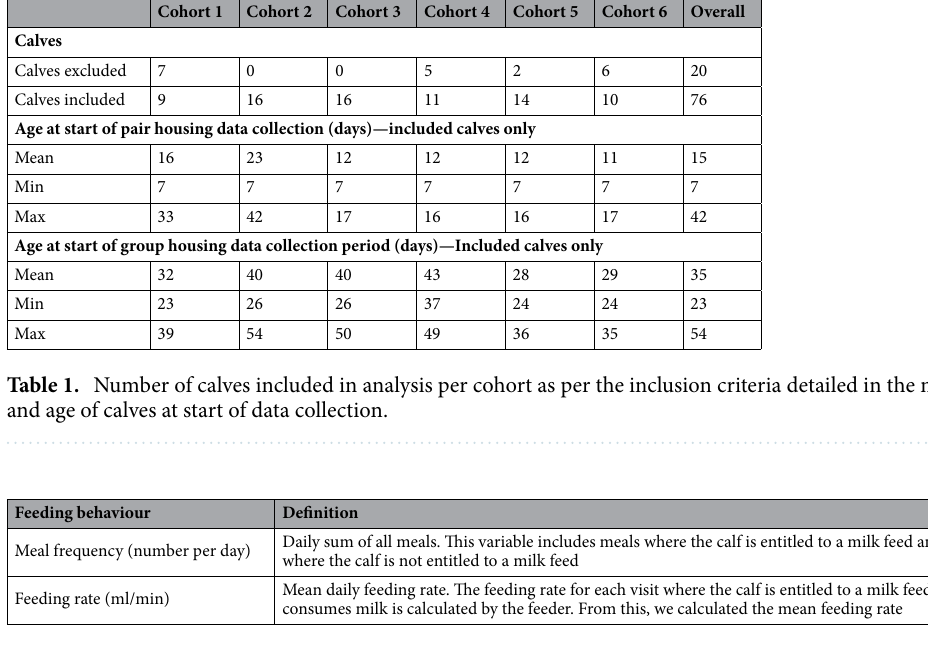
Table 2. Definitions of feeding behaviours used.